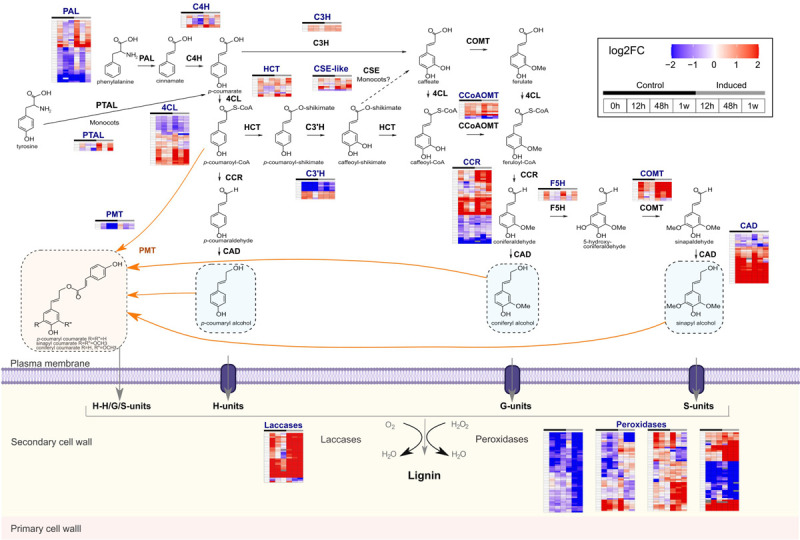
Representation of the monolignol biosynthetic pathway and the secondary cell wall domain embedded with expression data of lignin-related genes. Color code represents expression depicted as log2 fold change (FC) of transcripts per million (TPM) normalized by the expression value of each gene at 0 h. Only genes detected as differentially expressed in at least one comparison are shown. Each heatmap shows one hom(e)ologous genes per line for a given gene family and columns denote the different samples. Black and gray bars on the top of each heatmap indicate control and induced samples, respectively. Figure was adapted from MapMan4 (Schwacke et al., 2019) and includes all enzymatic steps toward monolignol biosynthesis, in addition to monolignol p-coumaroylation and oxidation. PAL, phenylalanine ammonia lyase; PTAL, bifunctional phenylalanine/tyrosine ammonia-lyase; C4H, cinnamate 4-hydroxylase; C3H, 4-coumarate 3-hydroxylase; 4CL, 4-coumarate-CoA ligase; HCT, p-hydroxycinnamoyl-CoA:quinate/shikimate p-hydroxycinnamoyltransferase; C3’H, 4-coumaroyl quinate/shikimate 3-hydroxylase; CSE, caffeoyl shikimate esterase; CCoAOMT, caffeoyl-CoA O-methyltransferase; CCR, cinnamoyl-CoA reductase; F5H, ferulate 5-hydroxylase/coniferaldehyde 5- hydroxylase; COMT, caffeate/5-hydroxyconiferaldehyde O-methyltransferase; CAD, cinnamyl alcohol dehydrogenase; PMT, p-coumaroyl-CoA:monolignol transferase.